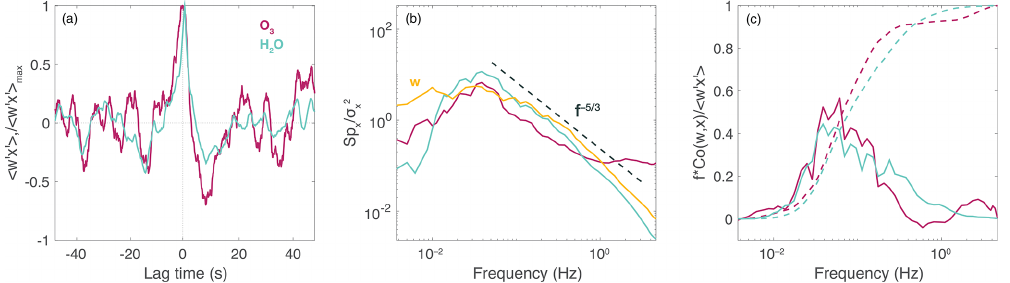
Figure 8. Example spectra from a 50km flux leg at 170m altitude during the 17 July 2019 flight over the Pacific Ocean. (a) Vertical-wind- scalar ( w and x , respectively) cross-covariance functions normalized by the maximum covariance for O 3 and water vapor. (b) Power spectra normalized to total variance for w , O 3 , and H 2 O. The dashed line represents the f − 5 / 3 theoretical decay for the inertial subrange. (c) Solid lines depict co-spectral power (frequency-multiplied and covariance-normalized) of O 3 and H 2 O with vertical wind. Dashed lines depict the respective ogives (cumulative